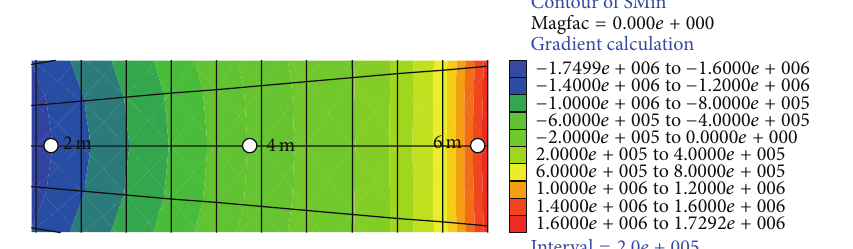
Figure 10: The maximum principal stress.